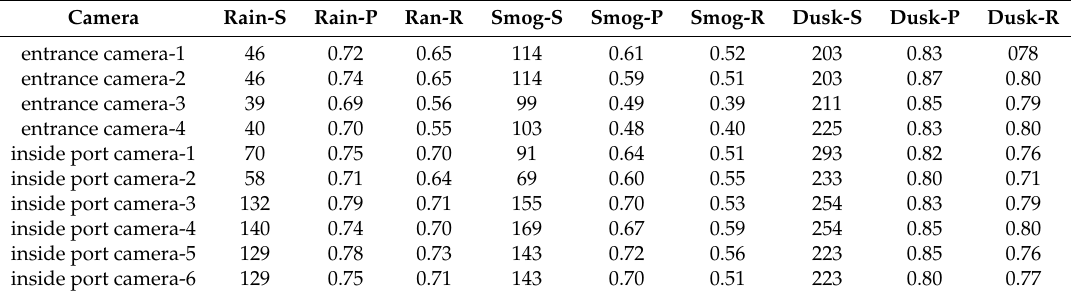
Table 9. Performance of ship detection in bad weather.